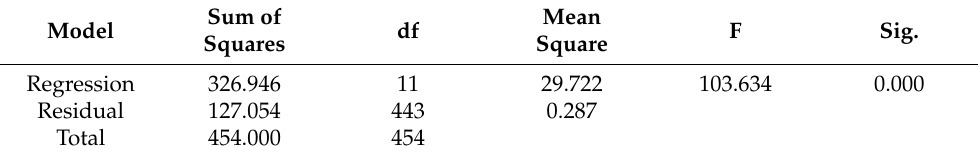
Table 6. F-test for the